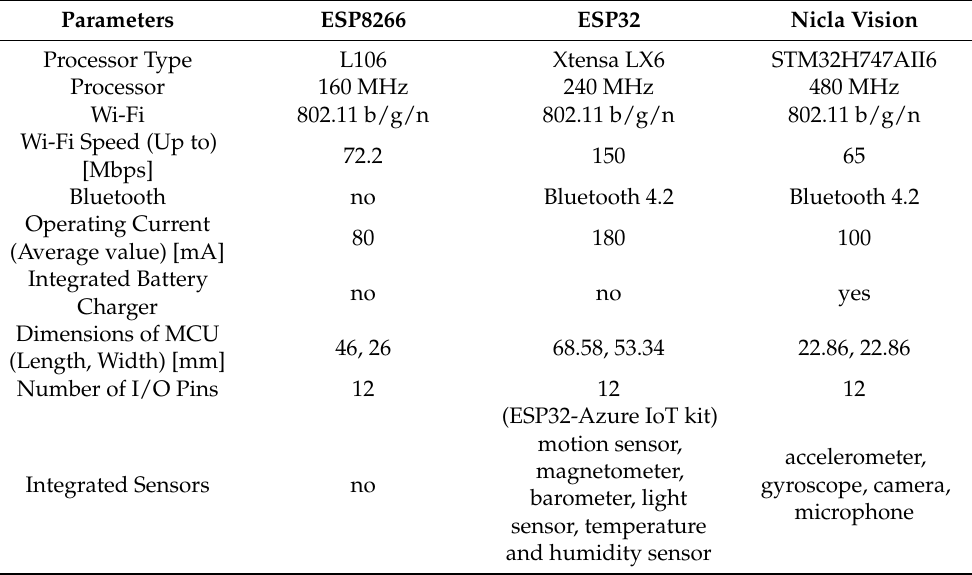
Table 4. This table shows the monitored parameters of microcontrollers used as a basis for an embedded device on an industrial